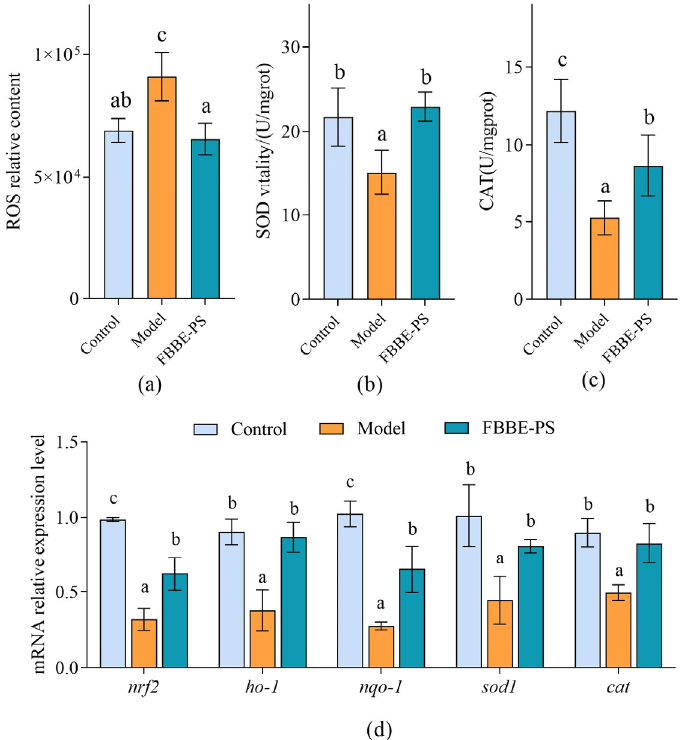
Figure 4. Effects of FBBE-PS (50 μ g/mL) on intracellular ROS levels ( a ), SOD activity ( b ), CAT activity ( c ) and expressions of antioxidation-related genes ( d ) in HepG2 cells. Data are presented as means ± SD, n = 3, different letters indicate significant differences between groups ( p < 0.05).